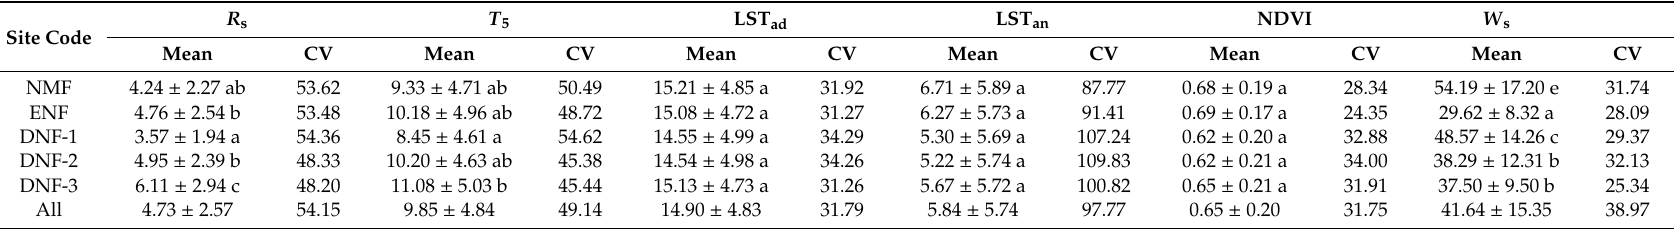
Table 3. Mean and coe ffi cient of variation (CV, %) of soil respiration ( R s , µ mol CO 2 m − 2 s − 1 ), soil temperature at the 5-cm depth ( T 5 , ◦ C), land surface temperature (LST ad and LST an , ◦ C), normalized di ff erence vegetation index (NDVI), and soil water content at 0 to 10 cm ( W s , %) at the five sites during measurement.